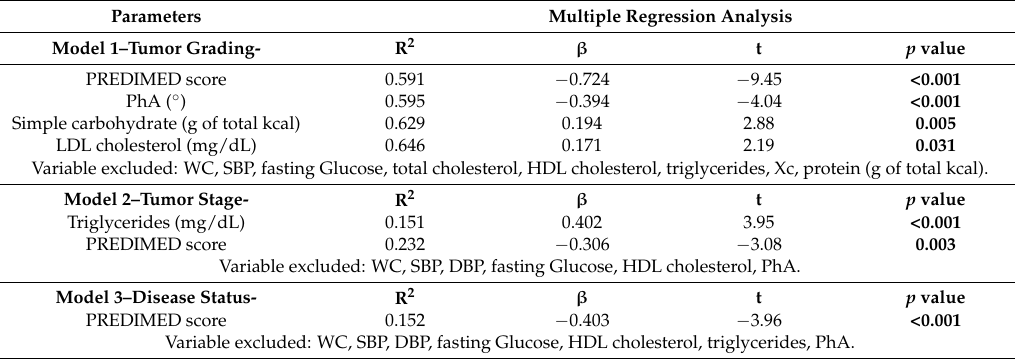
Table 7. Multiple regression analysis models (stepwise method) with tumor aggressiveness and nutritional parameters.